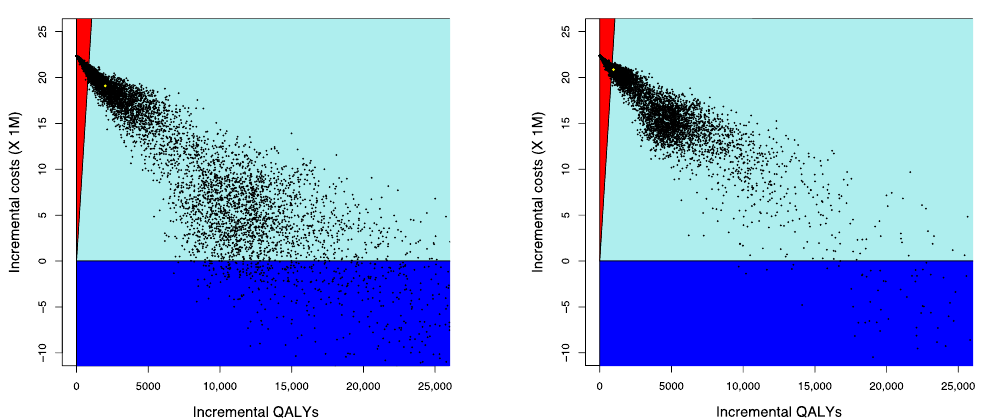
Figure 3. Cost-effectiveness scatter plots—incremental QALYs versus incremental costs (payer perspective). Note: dark blue represents cost-saving scenarios, the light blue sector represents results under € 25,000/QALY; red represents results over € 25,000/QALY; aQIV = adjuvanted quadrivalent influenza vaccine; QALY = quality-adjusted life-years Table 13. Vaccine acquisition and administration costs.